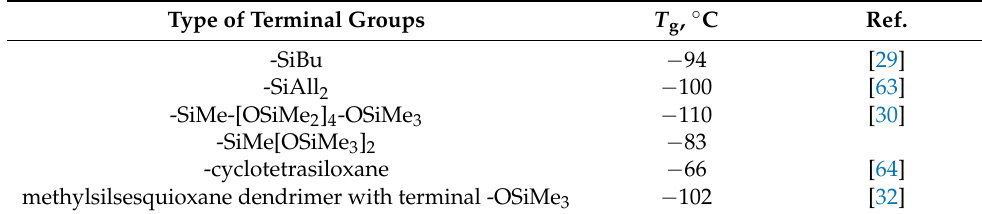
Table 1. Glass transition temperature of carbosilane dendrimers of the 3rd generation with terminal groups of different chemical nature.